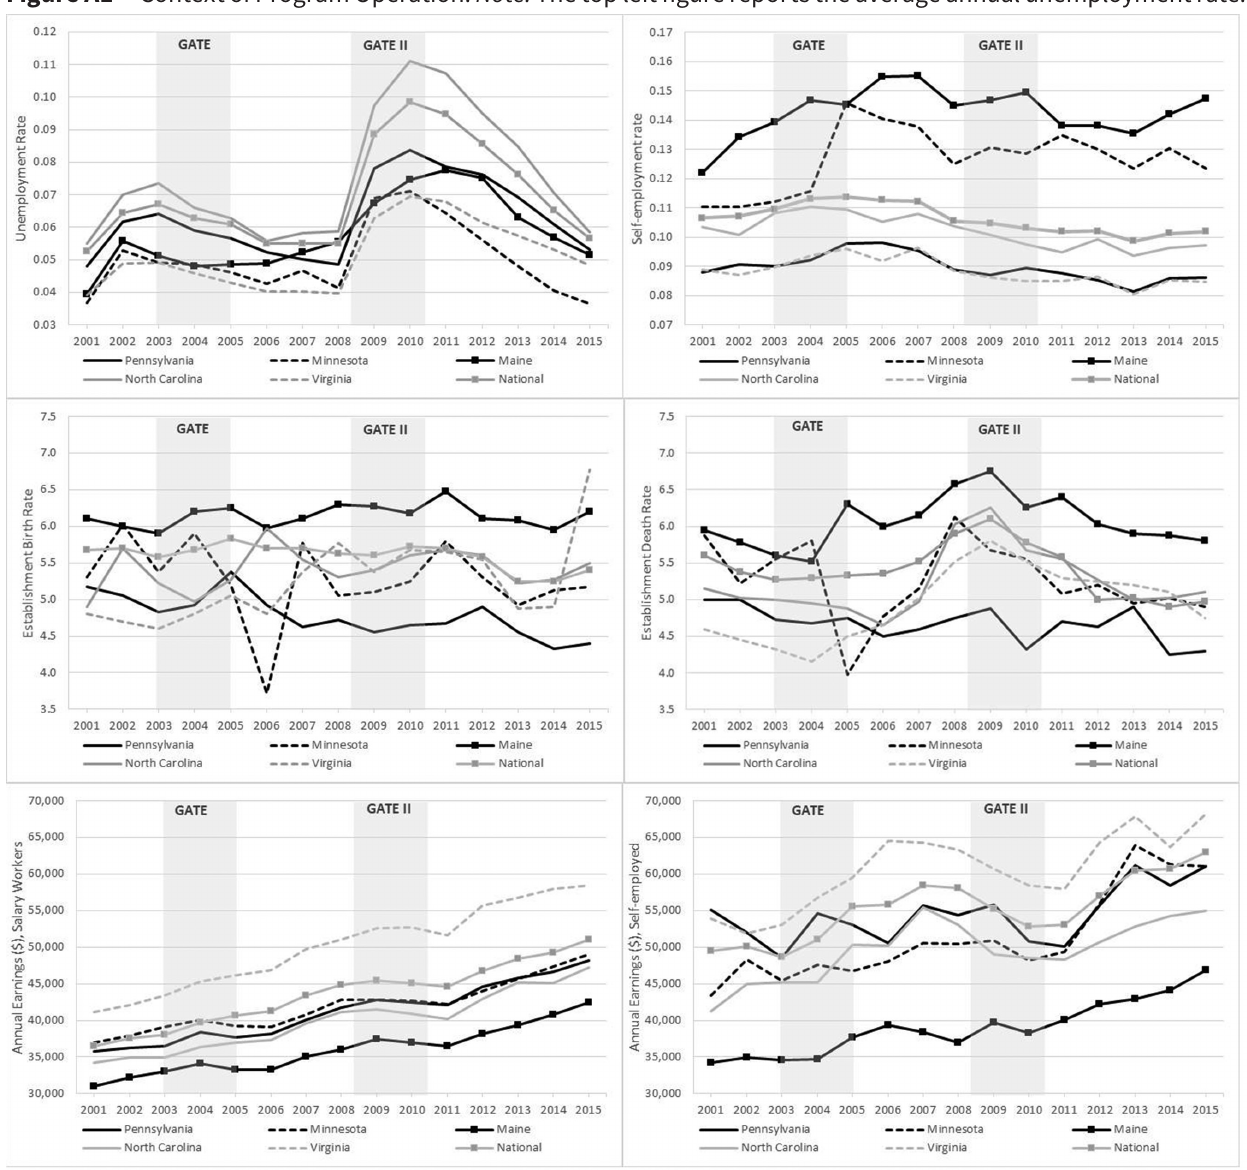
Context of Program Operation. Note: The top left figure reports the average annual unemployment rate.